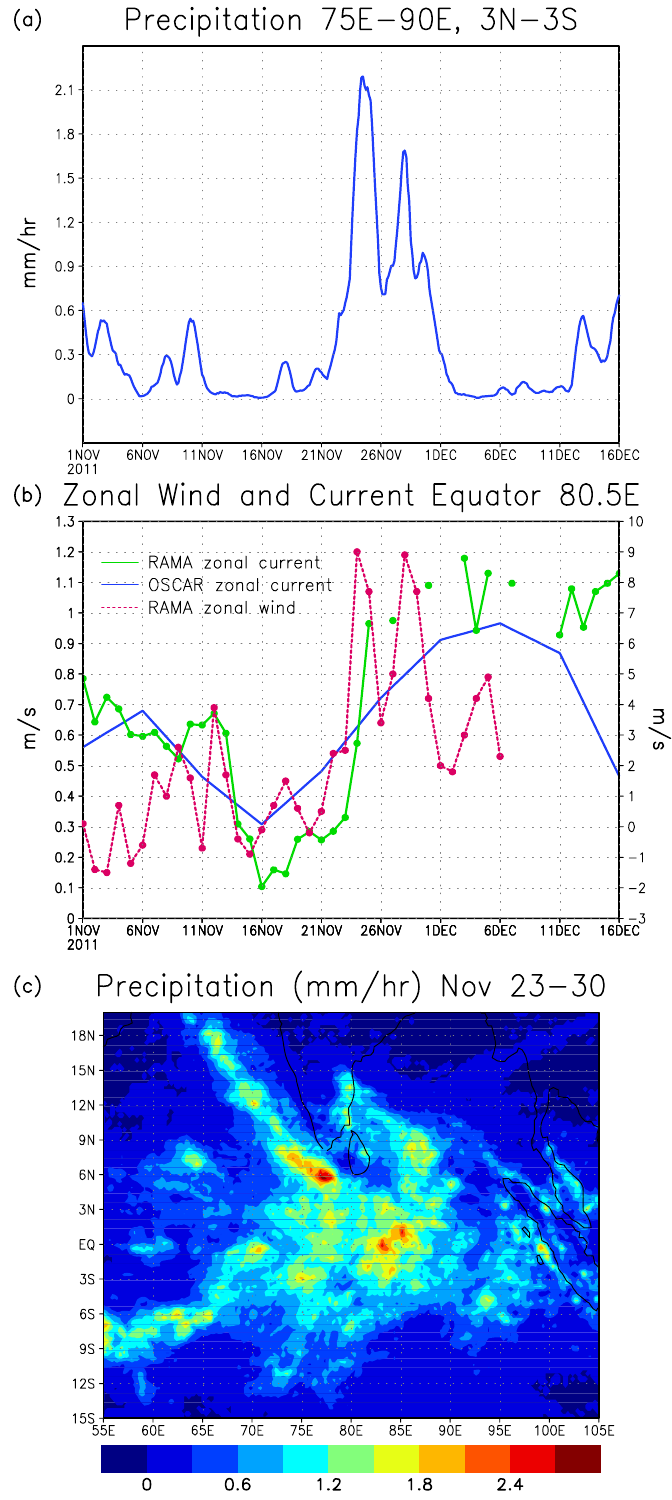
Figure 13. ( a ) Time series of precipitation averaged over 75°E–90°E, 3°N–3°S. ( b ) Time series of zonal wind and current at Equator, 80.5°E. Green lines indicate zonal current at 10 m depth from the RAMA buoy, and blue lines indicate near surface zonal current from OSCAR. Red dashed lines indicate zonal winds at 4m height measured by the RAMA buoy. ( c ) Average precipitation from TRMM 3B42 during 23–30 November